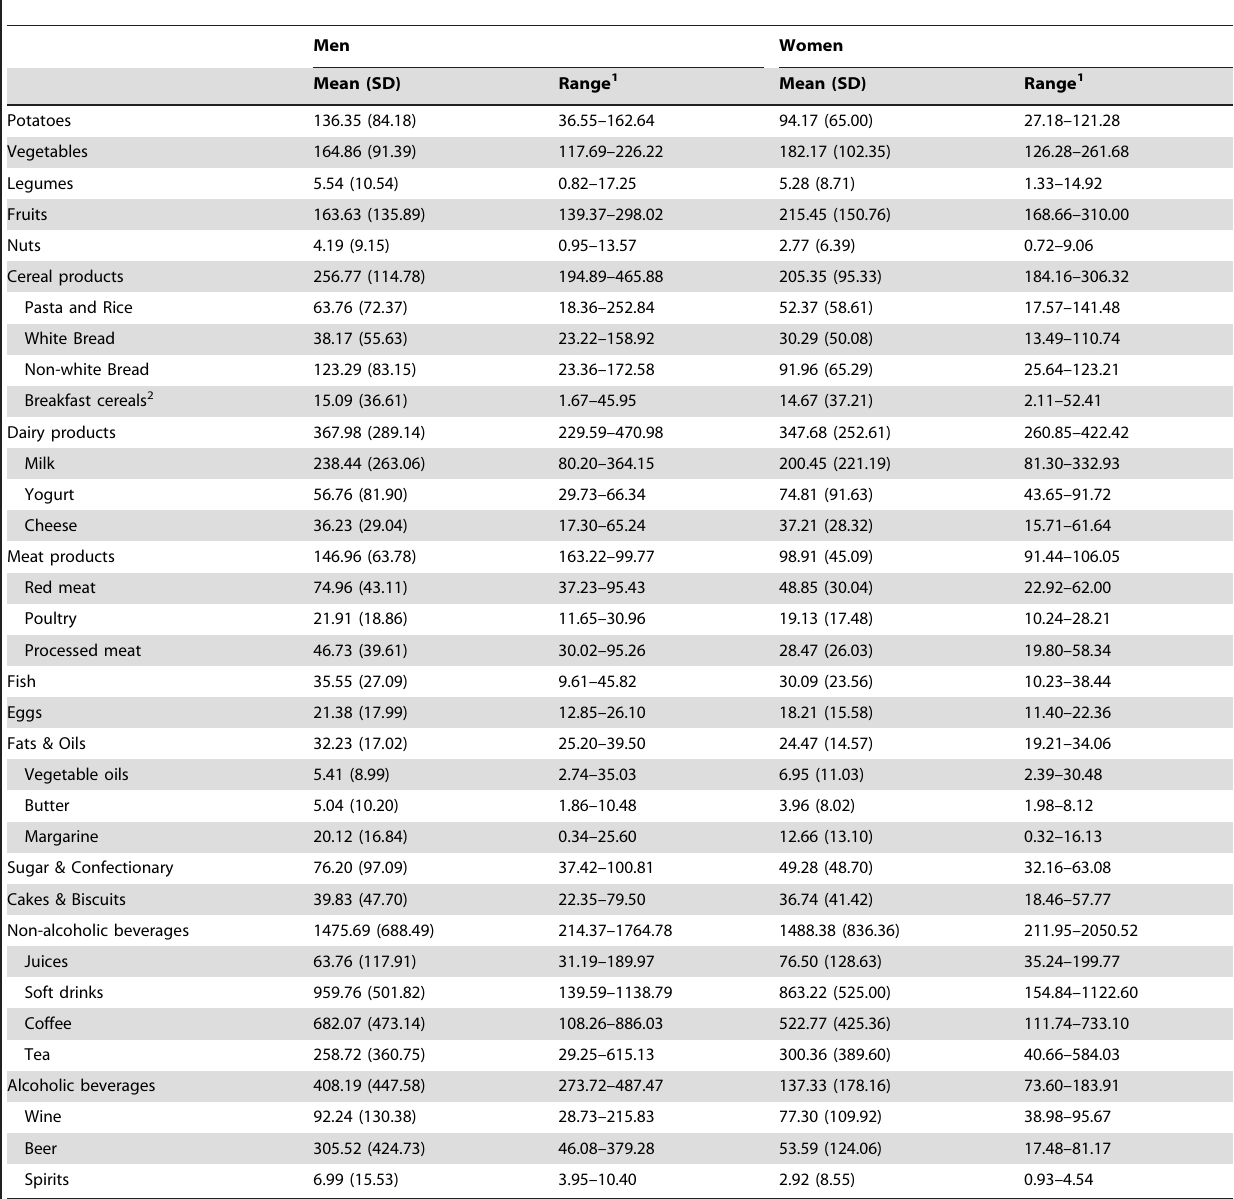
Table 1 . Average consumption of food groups/items (g/d) by gender in participants of the EPIC-DiOGenes project (n=